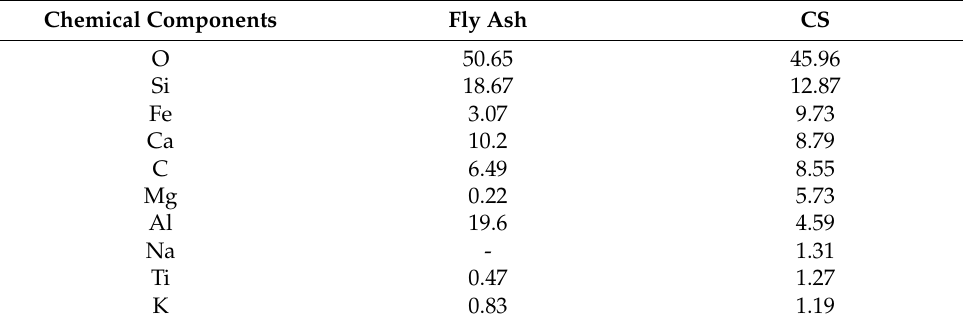
Figure 3. EDAX images of CS. Table 4. Chemical components of fly ash and copper slag.